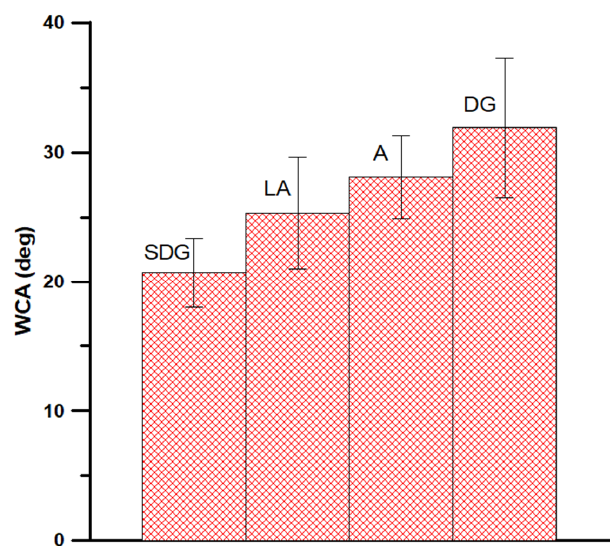
Figure 2. The average water contact angle (WCA) values for silicon (1,0,0) samples subjected to C 10 H 22 exposition at 298.15 K.